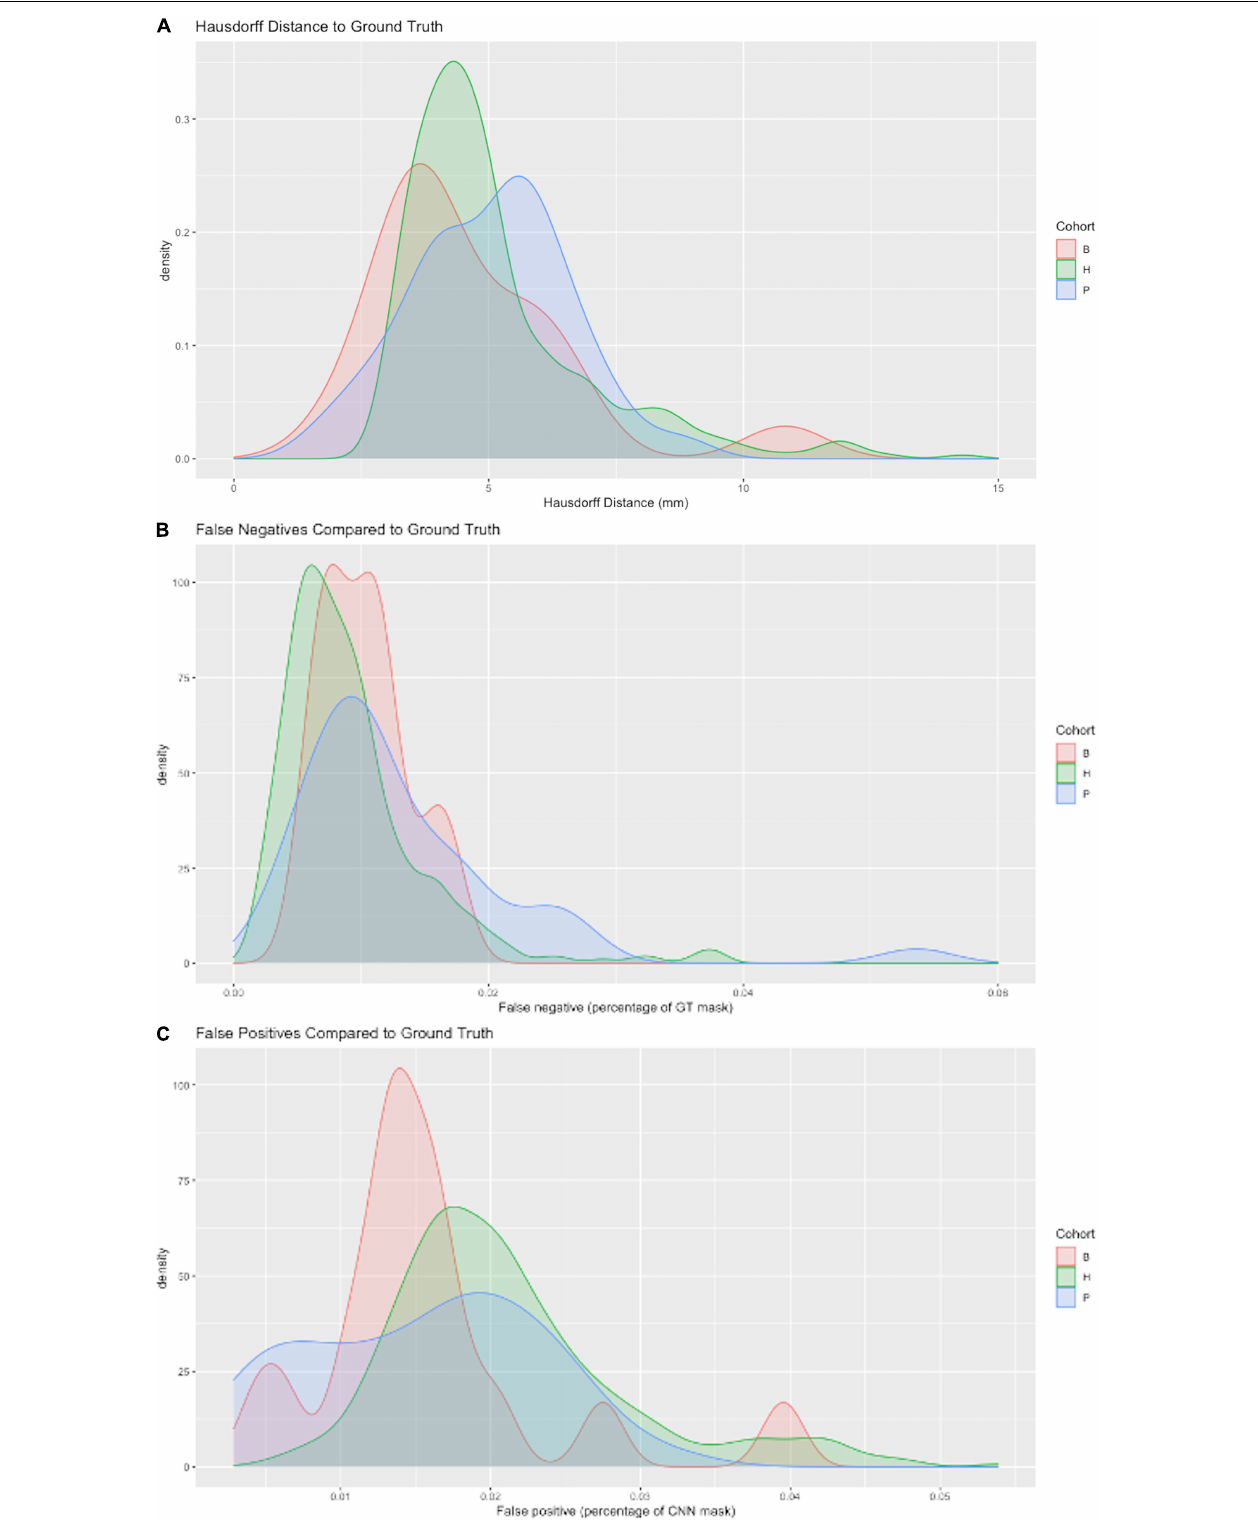
FIGURE 6 | Three metrics of model performance. In a randomly selected subset of the data, the best performing model was evaluated against GT masks using (A) Hausdorff distance (B) False negatives as a percentage of GT mask volume missed by CNN prediction and (C) False positives as a percentage of the CNN prediction incorrectly labeling areas outside GT mask. Results are depicted by probability density functions for each of three cohorts.